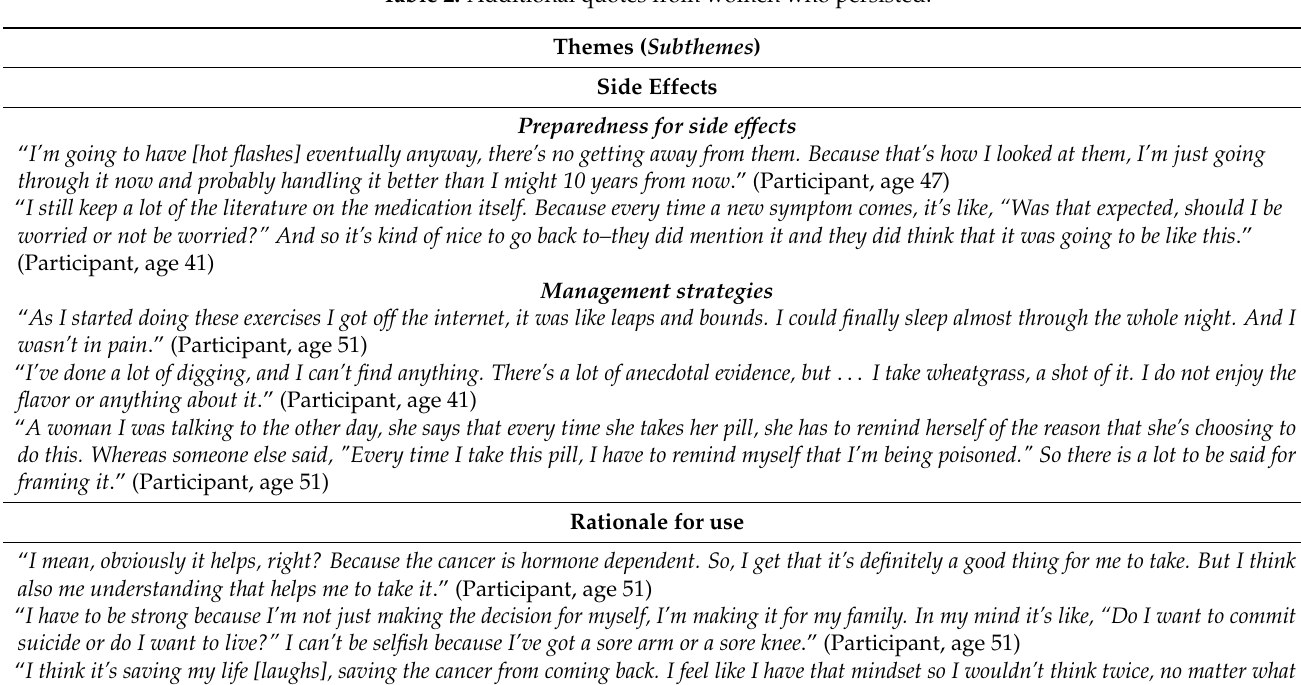
Table 2. Additional quotes from women who